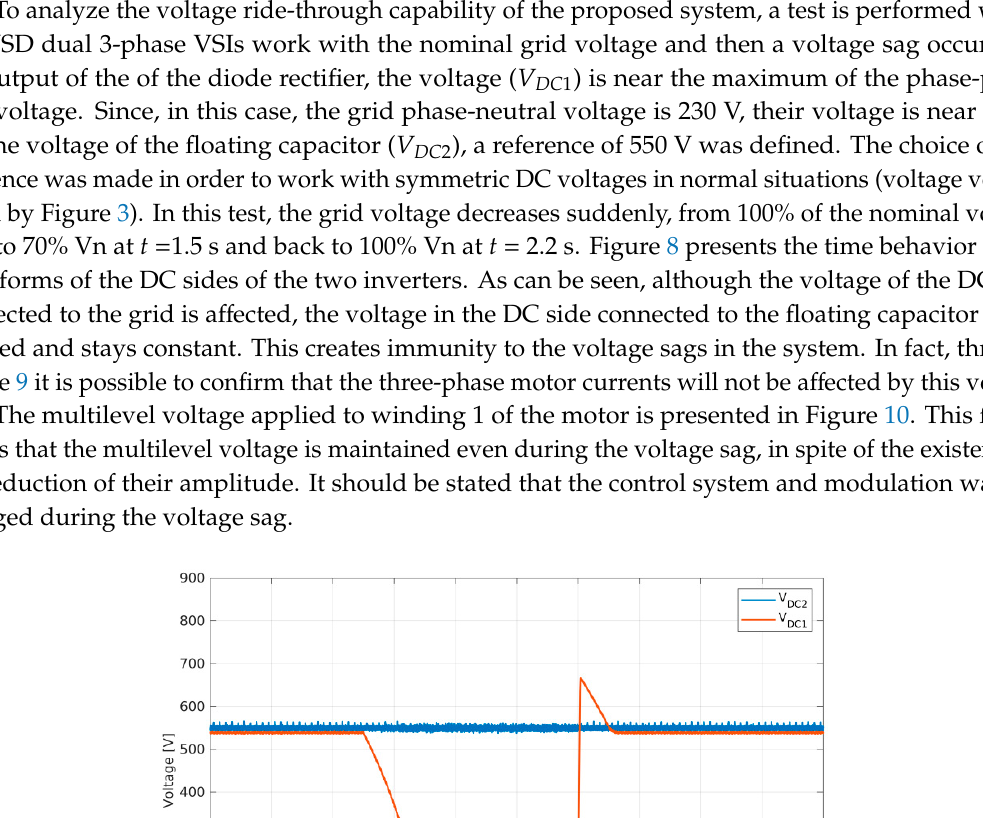
Figure 9. Three-phase currents with a voltage sag of 30%. Figure 10. Phase voltage applied to winding 1 with a voltage sag of 30%. Another similar test was made, but in this case the grid voltage decreased suddenly from 100% of the nominal voltage (Vn) to 30% Vn at t = 1.5 s and back to 100% Vn at t = 2.2 s. The time behavior